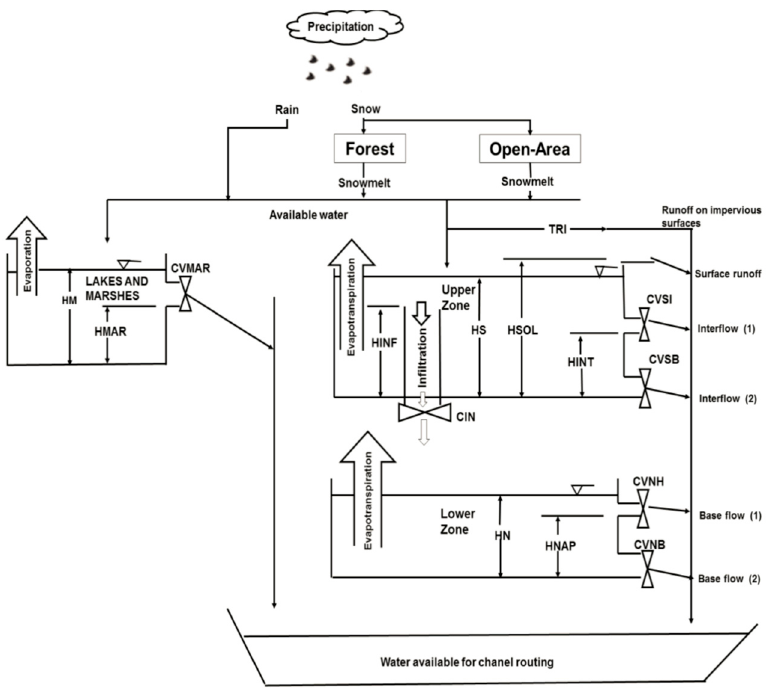
Figure 1. Production function vertical water routing in CEQUEAU (adapted from [17] and [24]).